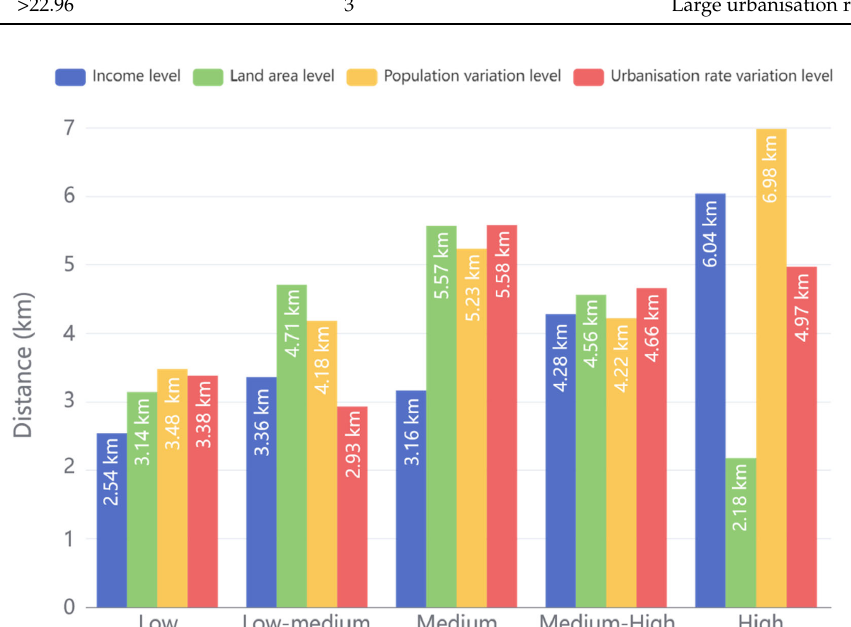
Figure 18. The average distance variation in relation to the indicators of the countries in which cul ‐ tural heritage sites are